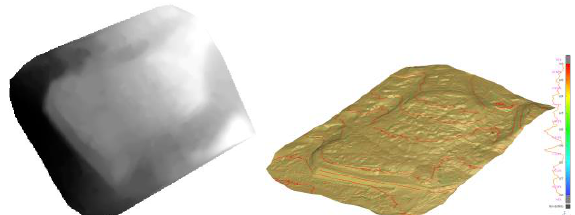
Figure 5. Digital terrain models used in HBIM modelling. (Left) DEM derived from UAV DSM. (Right) DEM generated from contours in Revit environment.